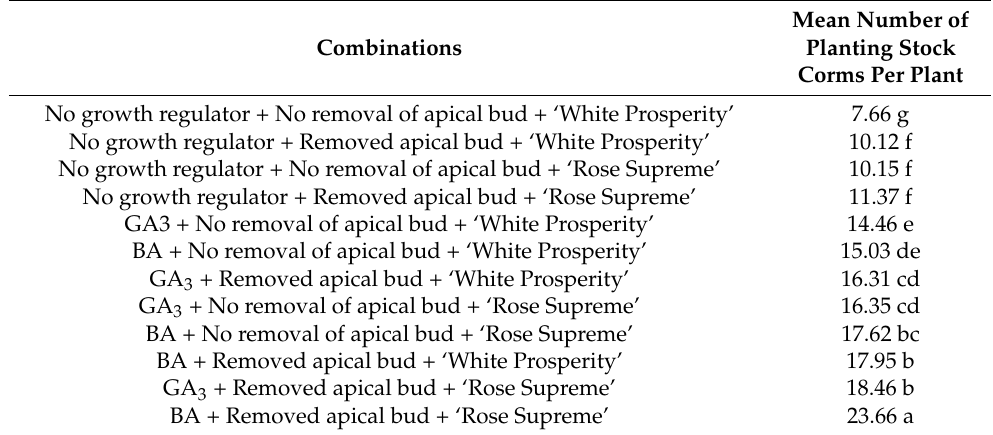
Table 3. Sorted mean number of planting stock corms per plant (from low to high) as influenced by the combination of growth regulators, apical bud removal, and varieties. Letters behind the numbers are results from the Duncan’s Multiple Range